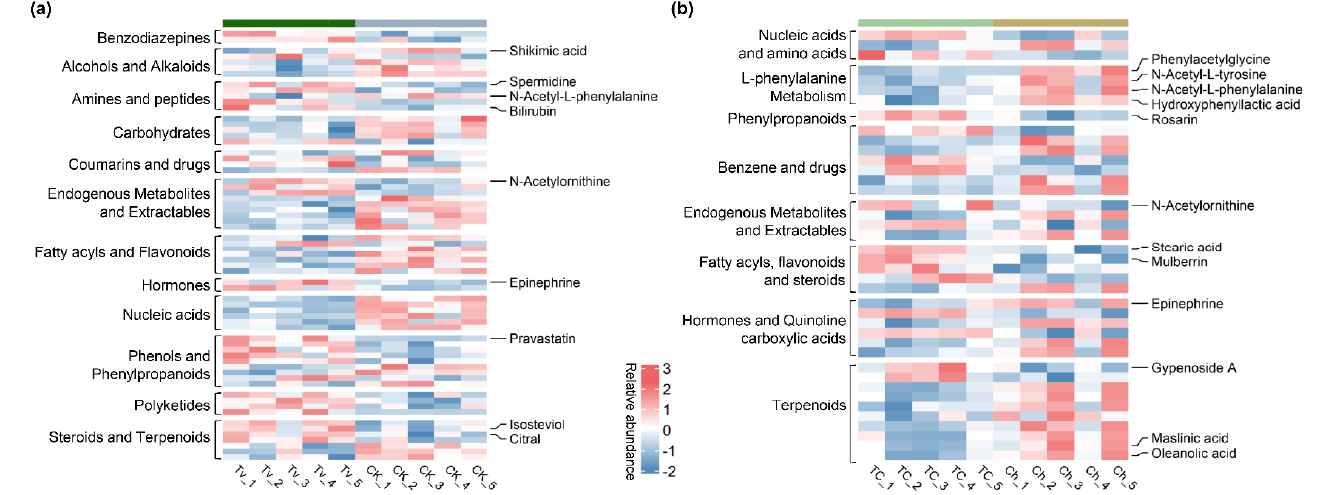
Figure 4. Untargeted metabolic profiling using the As leaves with T. virens colonization and C. homoeocarpa infection. ( a ) Heatmap of key metabolites with significantly different abundance (|log2FC|> 1.2, p ‐ value < 0.05 & VIP > 1) in the plants between Tv and CK group ( b ) Pairwise comparisons across inoculation with T. virens and C. homoecarpa (TC) and C. homoeocarpa -only inoculation (Ch) with the same settings as Figure 4a.